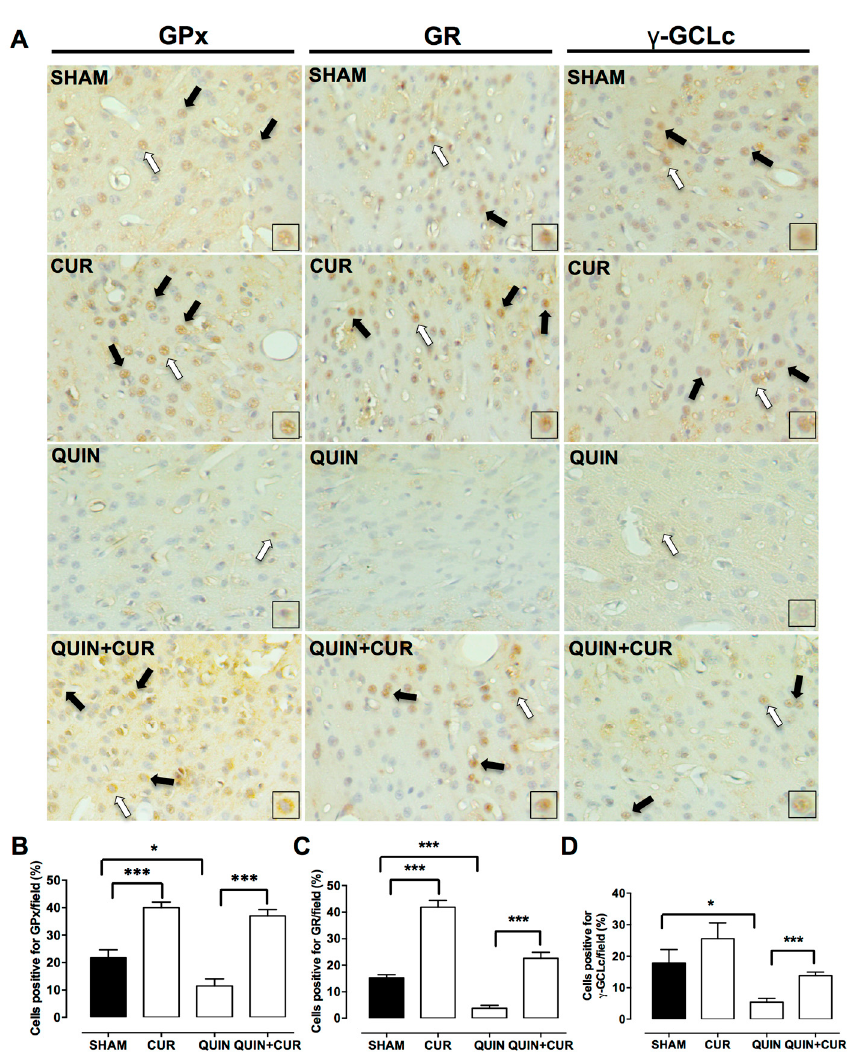
Figure 6. Effect of quinolinic acid (QUIN) and curcumin (CUR) on the protein levels of the enzyme regulated by the nuclear factor erythroid 2-related factor 2 (Nrf2). Immunohistochemistry assays were performed at day 7 after the quinolinic acid (QUIN) injection. Representative photomicrographs (40×) of cells positive for glutathione peroxidase (GPx), glutathione reductase (GR), and γ -glutamylcysteine ligase, catalytic subunit ( γ -GCLc) in the striatum are presented ( A ). Black arrows indicate cells positive for each protein. Boxes represent the magnified positive cells indicated by white arrows. Graphs indicate the percentage of cells positive for ( B ) GPx, ( C ) GR, and ( D ) γ -GCLc, counted in three randomly selected fields along the right striatum. Data are expressed as mean ± SEM (n = 5). * p < 0.05 and *** p < 0.001.